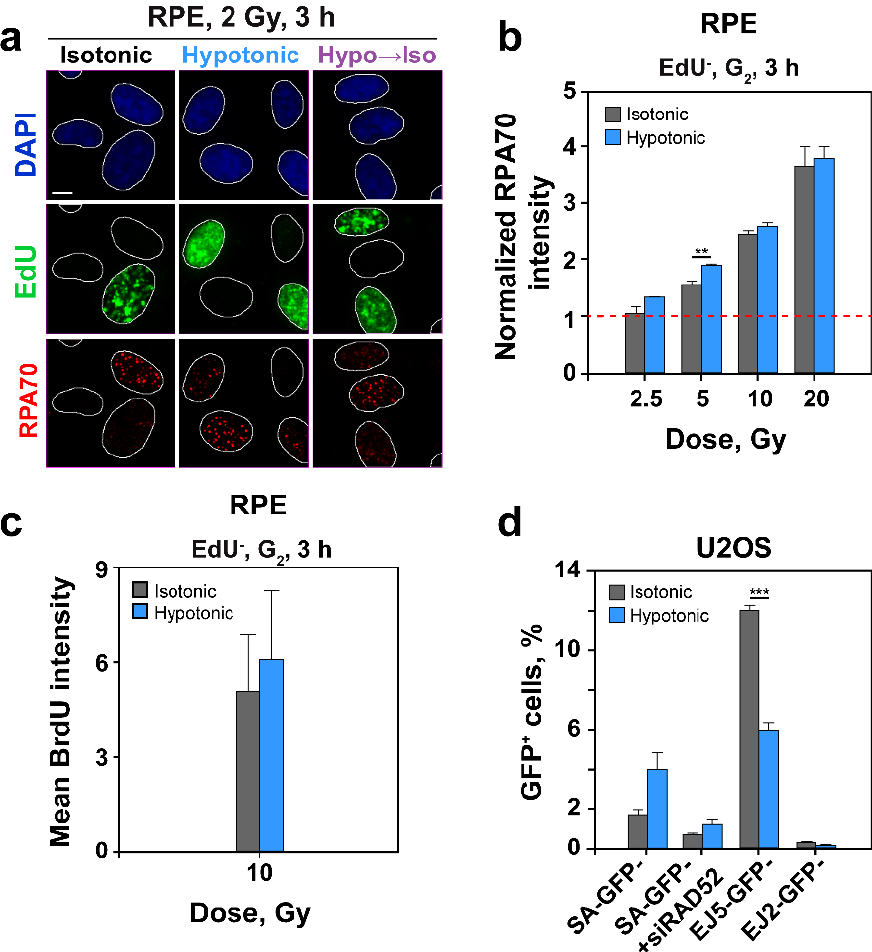
Figure 6. HypoS leaves DNA end-resection largely unchanged and enhances SSA. ( a ) Representative images of DAPI stained RPE nuclei showing EdU incorporation and RPA70 foci formation at 3 h post IR (2 Gy) in isotonically, hypotonically and transiently hypotonically (1 h) treated cells. Scale bar: 5 µm. ( b ) Arithmetic means of AF488 signal intensity for RPA70 measured by FC and gated for EdU − , G 2 -phase cells (as in Figure 2d) at 3 h post IR are normalized to the nonirradiated control values and plotted against IR dose. Means and SE are calculated from three experiments. ( c ) Arithmetic means of AF488 signal intensity for BrdU measured by FC and gated as in b for RPE cells maintained in isotonic (grey bar) and hypotonic medium (blue bar) for 3 h post 10 Gy IR. Means and errors are calculated from three independent experiments. ( d ) Percentage of GFP positive cells in U2OS SA-GFP, EJ5-GFP and EJ2-GFP reporter cell lines, 24 h after transfection with an I- Sce I expressing plasmid and treatment in hypotonic or isotonic medium. RAD52 knockdown in SA-GFP cells was carried out 24 h prior to treatment and in parallel with transfection of I- Sce I expressing plasmid. Grey bars: control cells in isotonic medium; blue bars: cells maintained in hypotonic medium. Means ± SE calculated from two to three independent experiments are shown. For all plots the significance of differences between individual measurements under isotonic and hypotonic conditions is indicated by the asterisk: ** p < 0.01 and *** p < 0.001.